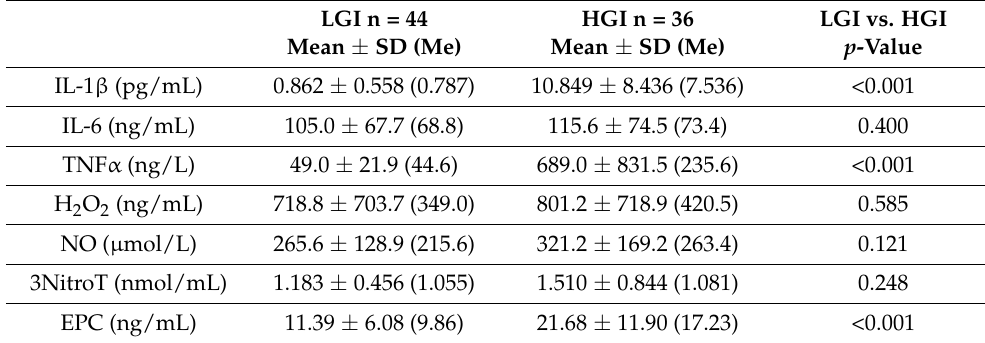
Table 4. Inflammatory and endothelium-specific variables.